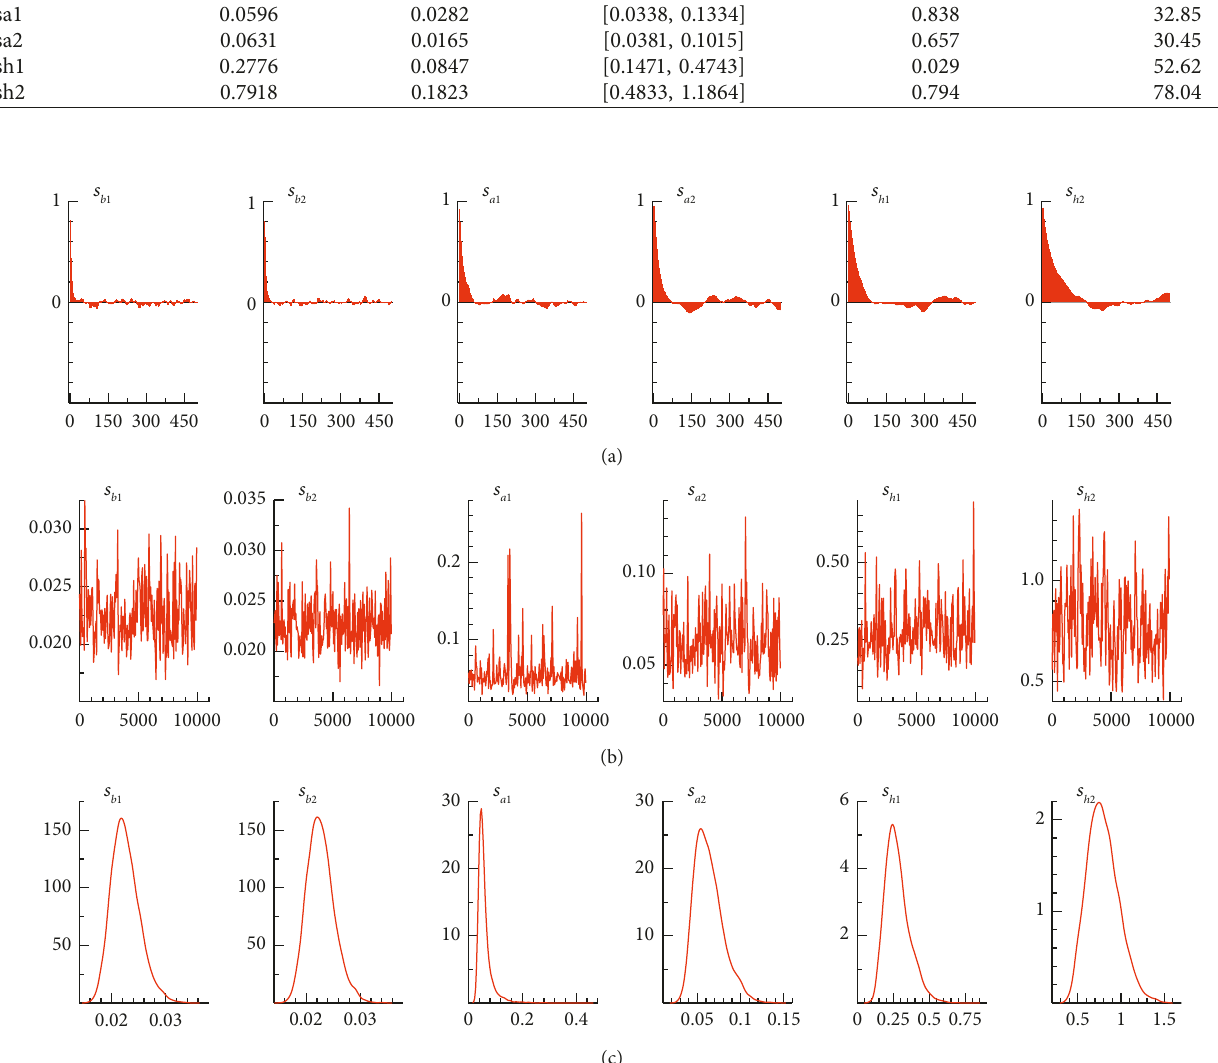
Figure 5: Estimation results of parameters in the TVP-SV-VAR Model. Sample autocorrelations (a), sample paths (b), and posterior densities (c).